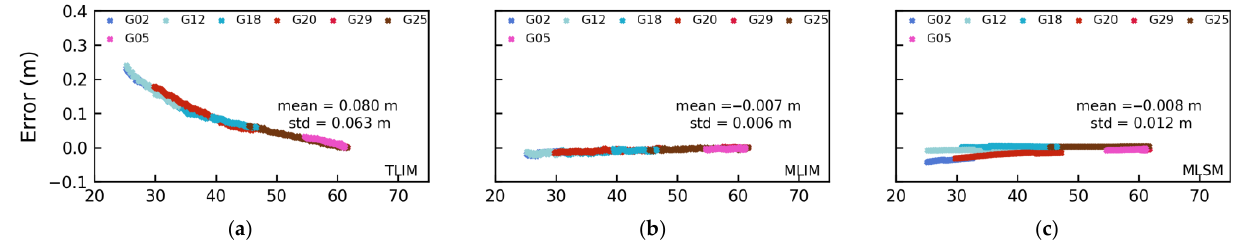
Figure 6. Variation trend of DD tropospheric errors for different satellites with a change in elevation calculated by TLIM ( a ), MLIM ( b ), and LSM ( c